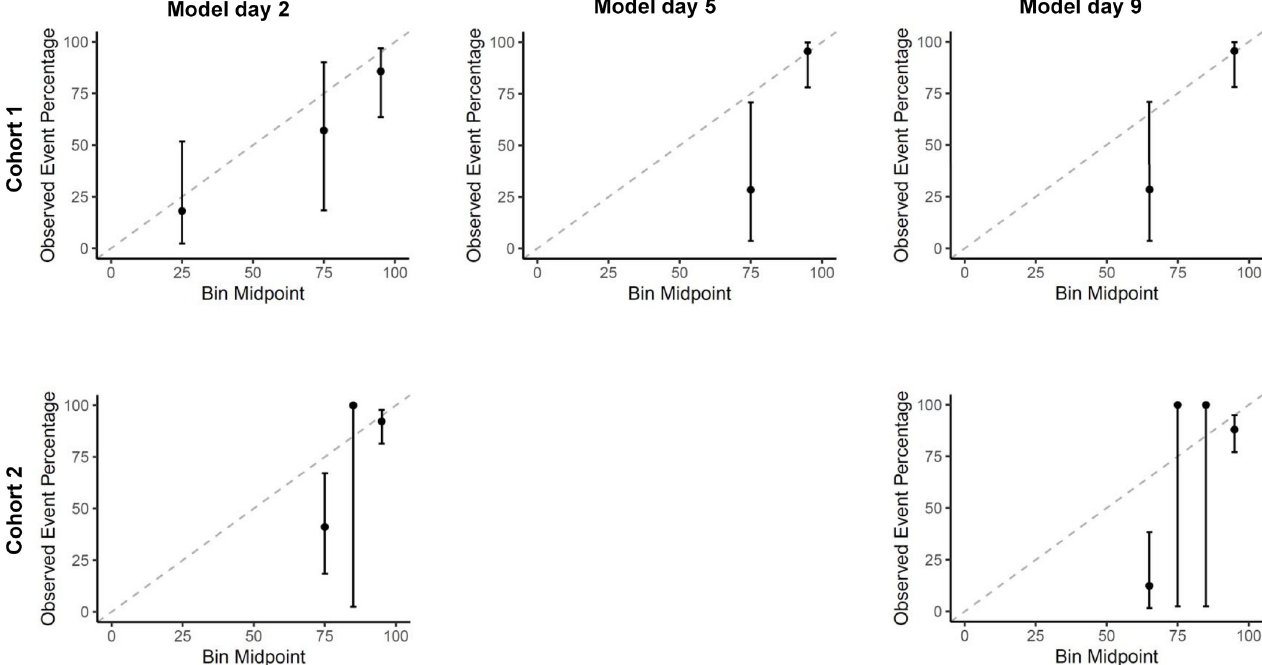
Fig 5. Calibration plots for the external validation of the EPOS model for an ARAT cut-off at 32 points. Analysis based on the imputed data. The model for day 5 was not externally validated in Cohort 2. The dotted line indicates perfect calibration, meaning that the predicted probabilities by the EPOS model (x- axis) and the observed probabilities in our sample (y-axis) are similar. ARAT, Action Research Arm